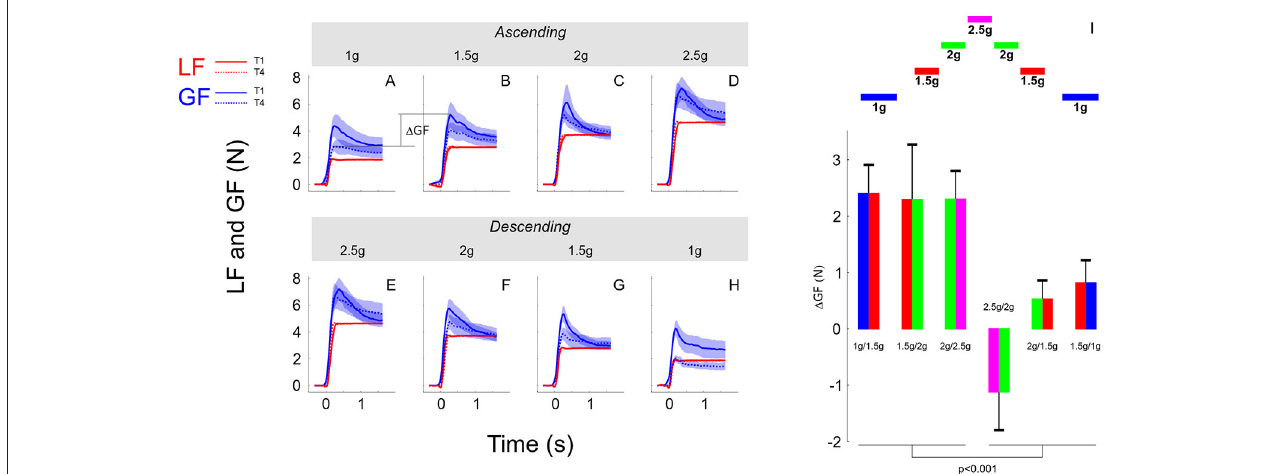
FIGURE 6 | (A–H) Grip force (blue traces) and load force (red traces) over time plotted in each gravitoinertial environment and for the first (T1, solid lines) and last (T4, dashed lines) trial. Traces were the averages across 7 participants and the shaded area corresponds to SEM. Notice that load force overlapped closely between T1 and T4 in all conditions. The upper row (A–D) corresponds to the ascending phase and the lower row depicts time series in the descending phase (E–H) . For clarity, since we had only one 2.5g environment, D,E present the same data. The index 1 GF (illustrated in A ) quantifies the switching between environments and is calculated as the first grip force peak in the next environment (at trial 1) minus the last grip force peak reached in the current environment (at trial 4). (I) Average and SEM of 1 GF for each of the six transitions. Bar plots are bicolour; left color corresponds to the current environment and right color corresponds to the next environment (refer to the sketch above).